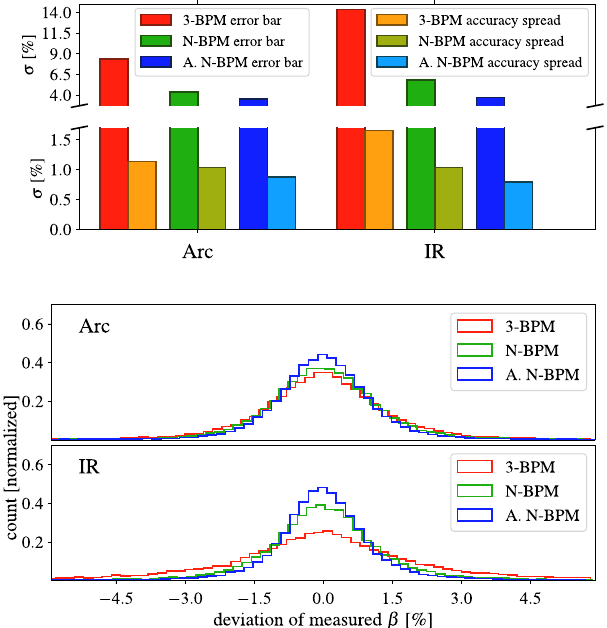
FIG. 7. Horizontal β beating of beam 1 at β (cid:1) ¼ 10 cm during the ATS MD 2016. Top: 3-BPM method. Bottom: analytical N-BPM method. The 3-BPM method suffers from bad phase advances and has many outliers. The regions of high β beating at around 8000 m and 23000 m lie in the telescopic